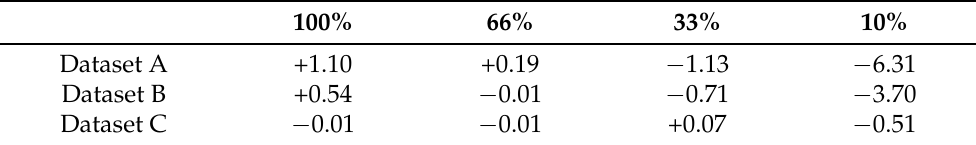
Table 8. D K by changing the total number of